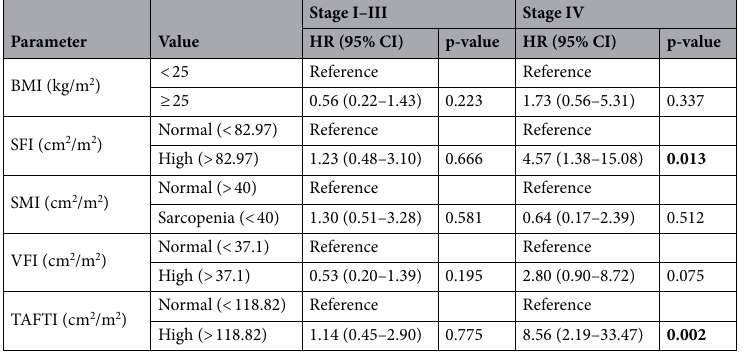
Table 3. Correlation between PFS and body composition parameters classifying patients based on the stage at the diagnosis. Significant values are in bold. HR hazard ratio (from Cox regression models), CI confidence interval, BMI body mass index, SMI skeletal muscle index, SFI subcutaneous fat index, VFI visceral fat index, TAFTI Total abdominal fat index.